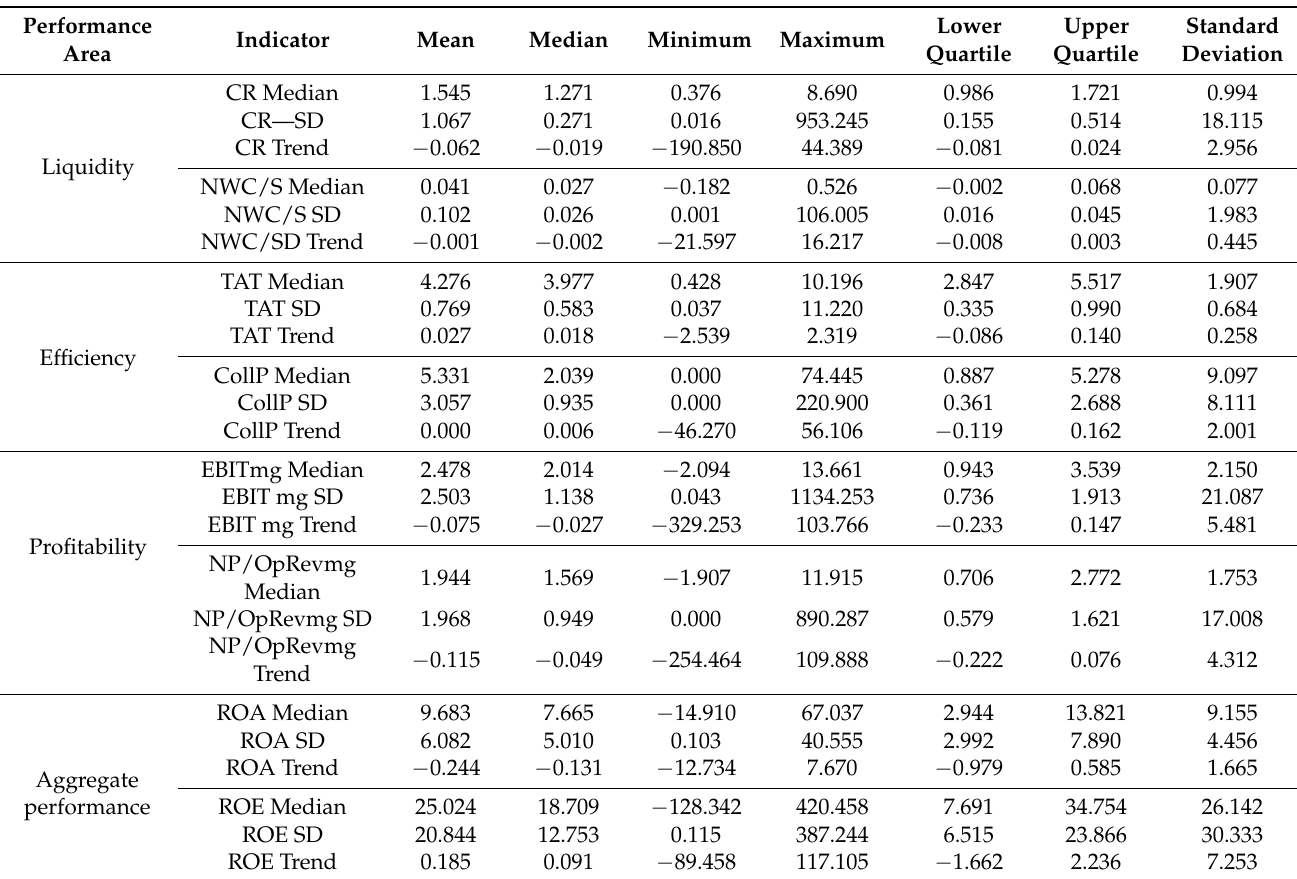
Table 5. Liquidity, profitability, efficiency, and aggregate performance indicators, full sample,